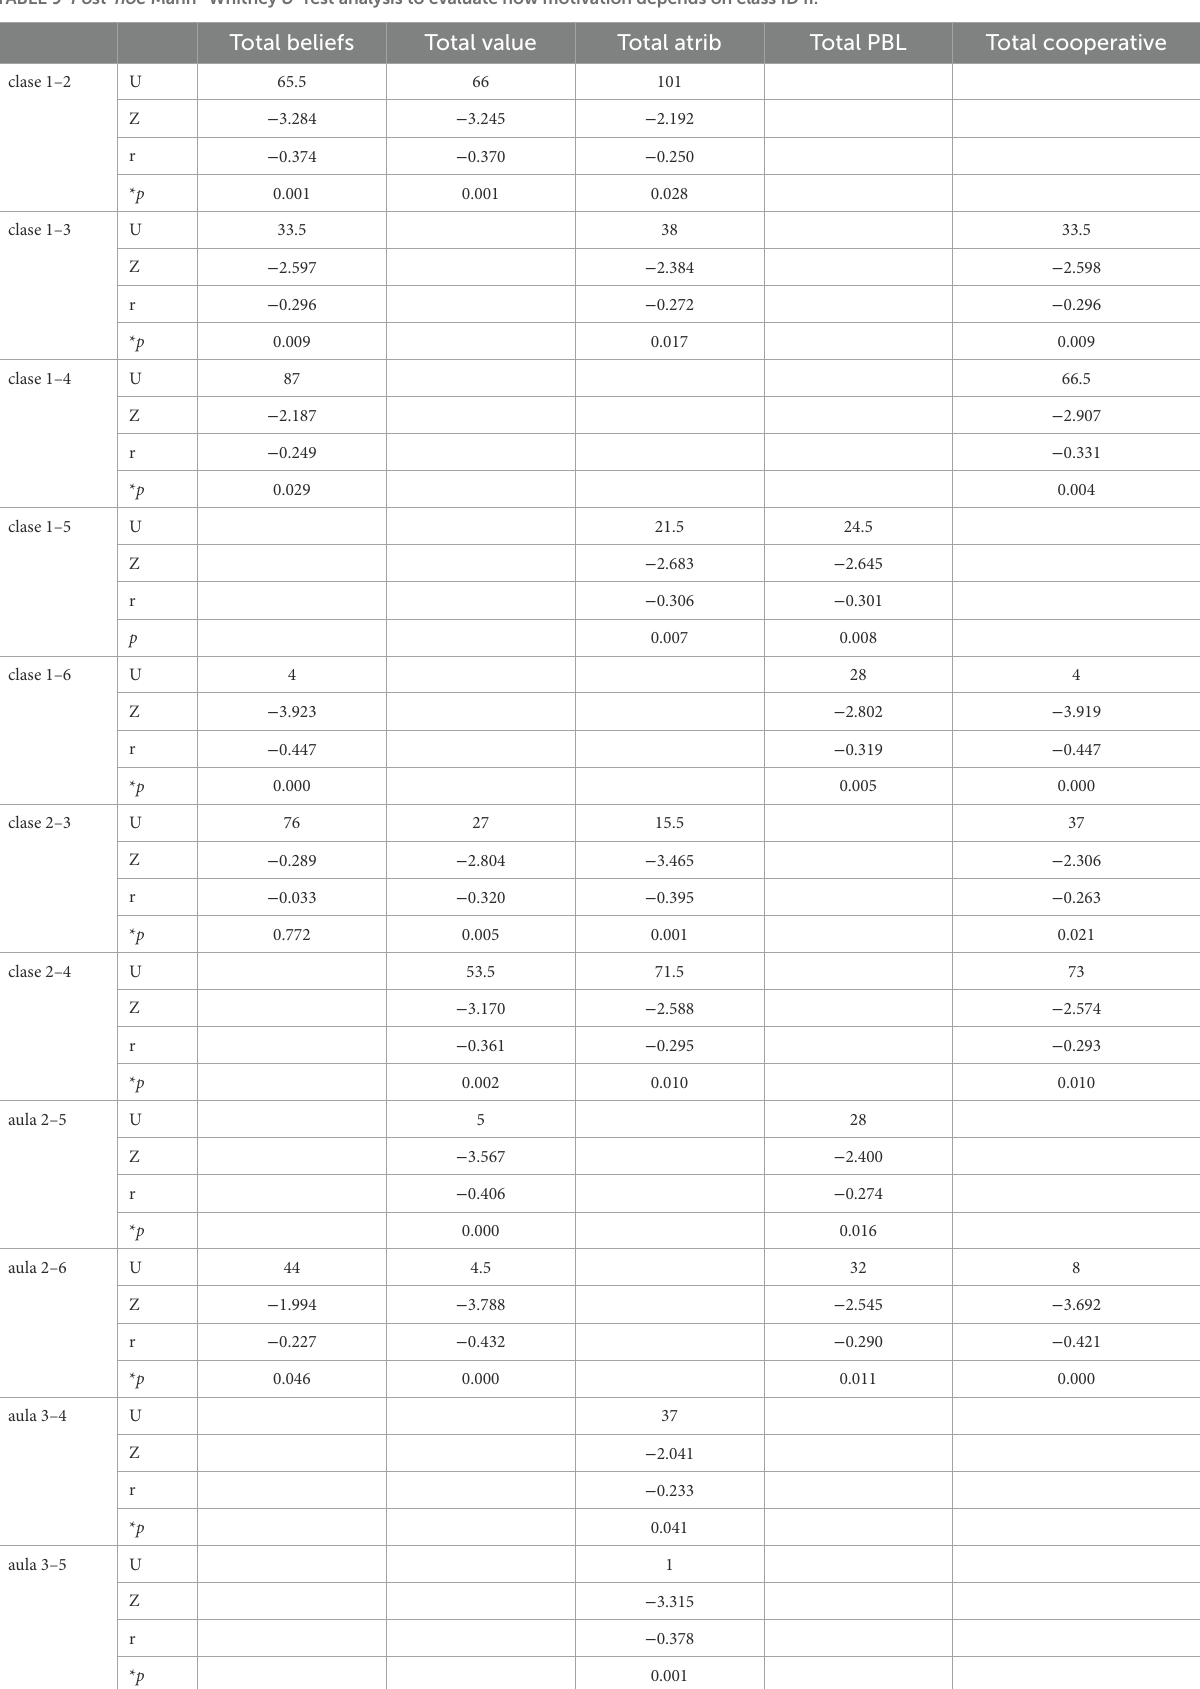
TABLE 9 Post-hoc Mann–Whitney U -Test analysis to evaluate how motivation depends on class ID II. Total beliefs Total value Total atrib Total PBL Total